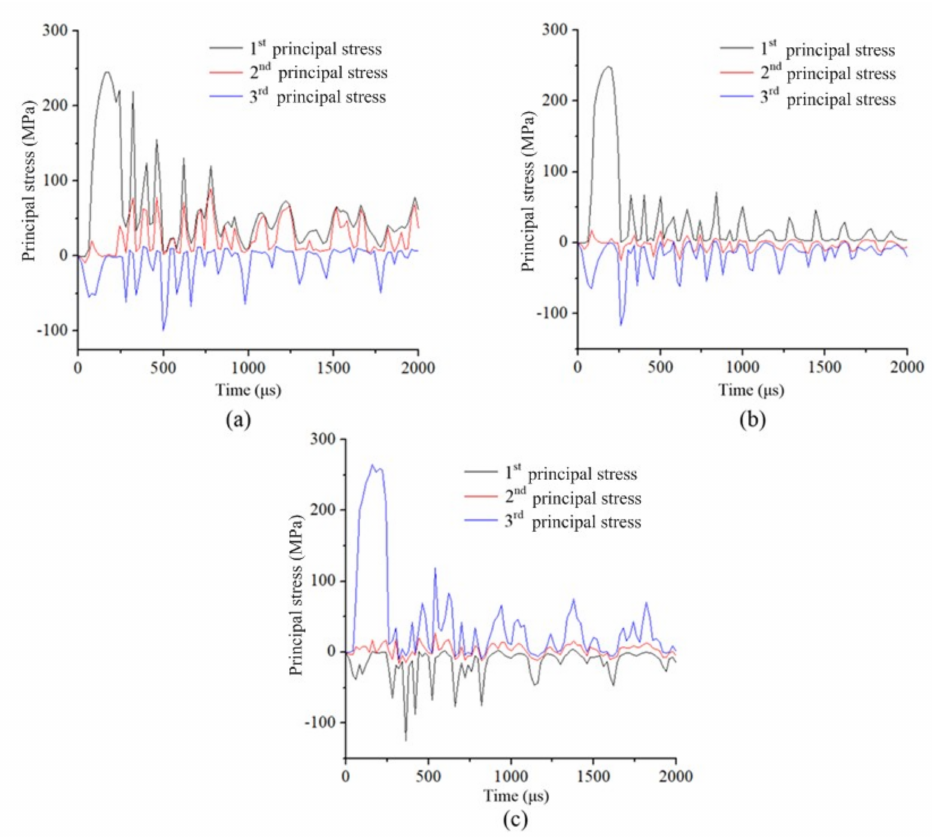
Figure 13. Relationship between time and principal stress at special nodes: ( a ) node 305, ( b ) node 313, and ( c ) node